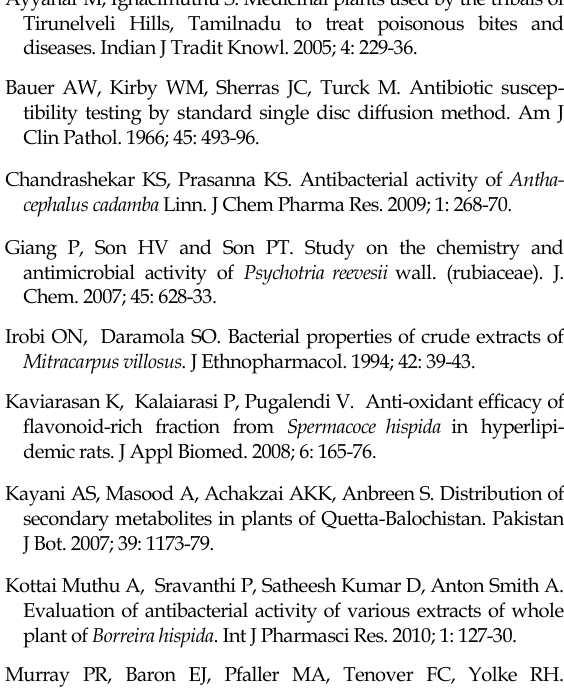
Antifungal activity of R.